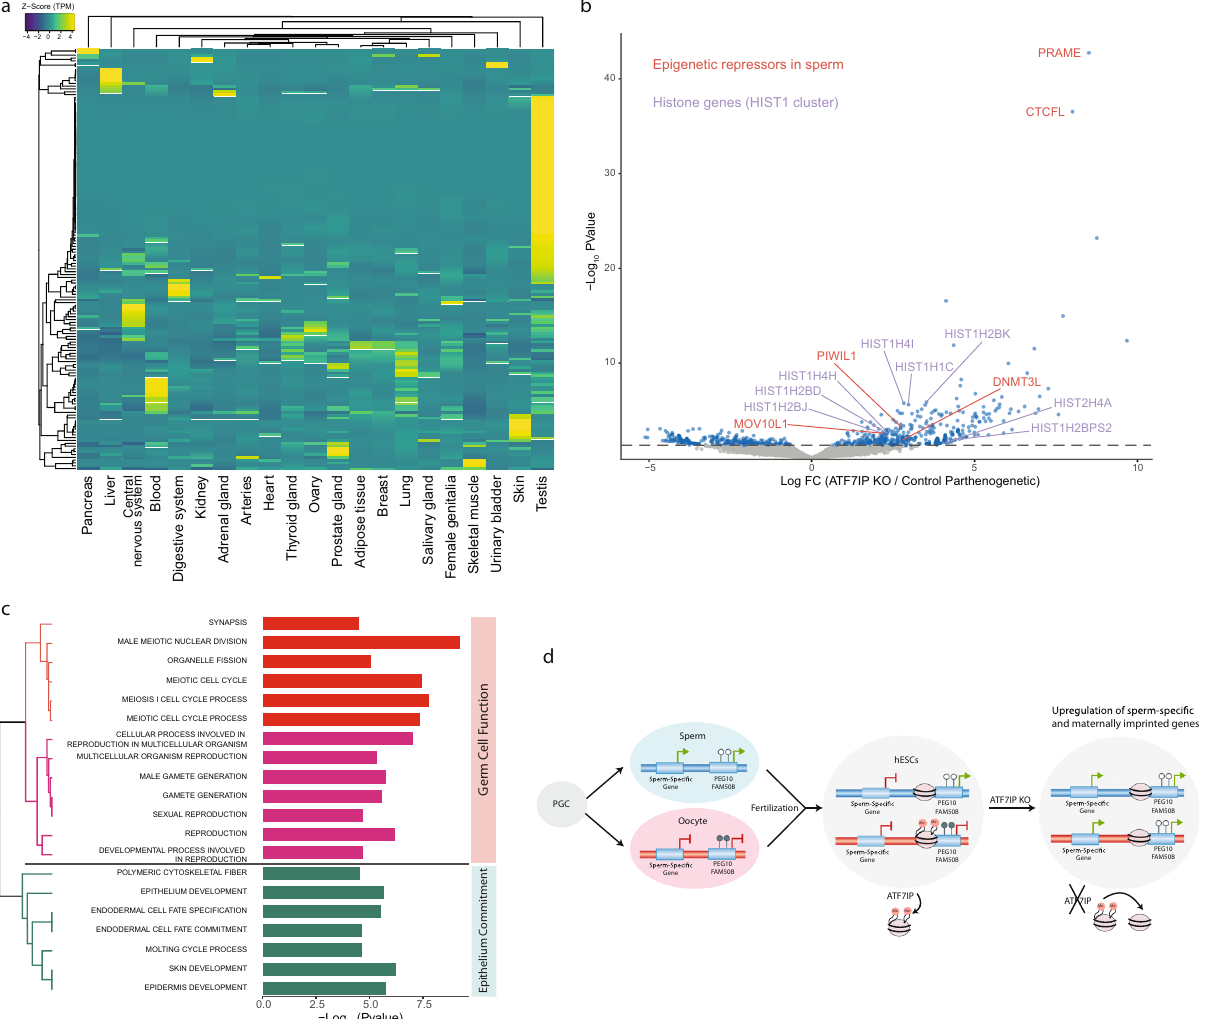
Fig. 4 ATF7IP KO induces expression of genes involved in spermatogenesis. a Heatmap of expression levels ( Z score TPM) across tissues (data from the GTEx study) of all the upregulated genes in ATF7IP KO cells (158 genes as identi fi ed in ( b ), log FC > 2 and P value < 0.05). b Volcano plot of differential expression (calculated by edgeR) showing the log 2 fold change (FC) between ATF7IP KO and control (empty Cas9 vector) hpESCs for all genes ( x axis, n = 3 replicates from each cell type). y Axis represents − log P value. Marked in blue are genes with P value < 0.05. Upregulated genes from the HIST1 10 gene cluster are highlighted in purple and representative epigenetic repressors that are mostly active in sperm are shown in red. c Top 20 enriched gene ontology (GO) terms (analyzed by GSEA, FDR q values < 0.05) among the upregulated protein-coding genes following ATF7IP KO (158 genes that were identi fi ed in ( b ), log FC > 2 and P value < 0.05, excluding HIST1 genes). x Axis represents − log 10 P value (hypergeometric distribution, as calculated by GSEA). Hierarchical clustering for the GO terms was applied based on a matrix of genes associated with each term ( “ Manhattan ” distance measure) and colored accordingly. d An illustration summarizing our model for ATF7IP activity in hESCs. Sperm-speci fi c and imprinted paternally expressed genes (PEGs) are differentially expressed between oocyte and sperm and are silenced by ATF7IP in hESCs. PEGs are only repressed from the maternal allele, whereas sperm-speci fi c genes are completely silenced. Following ATF7IP KO, these genes are activated, resulting in upregulation of a group of sperm- speci fi c and paternally expressed